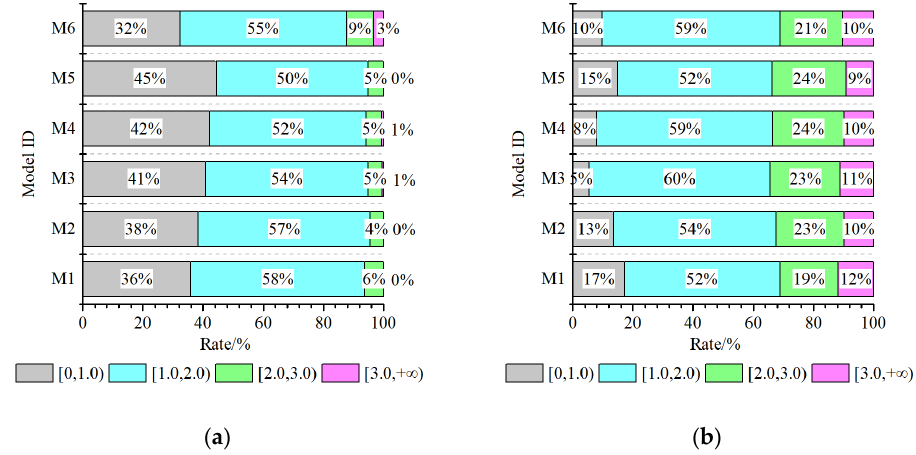
Figure 22. The average beam hinge rate: ( a ) a PG, x = 0.4 g; ( b ) a PG, x = 0.62 g.